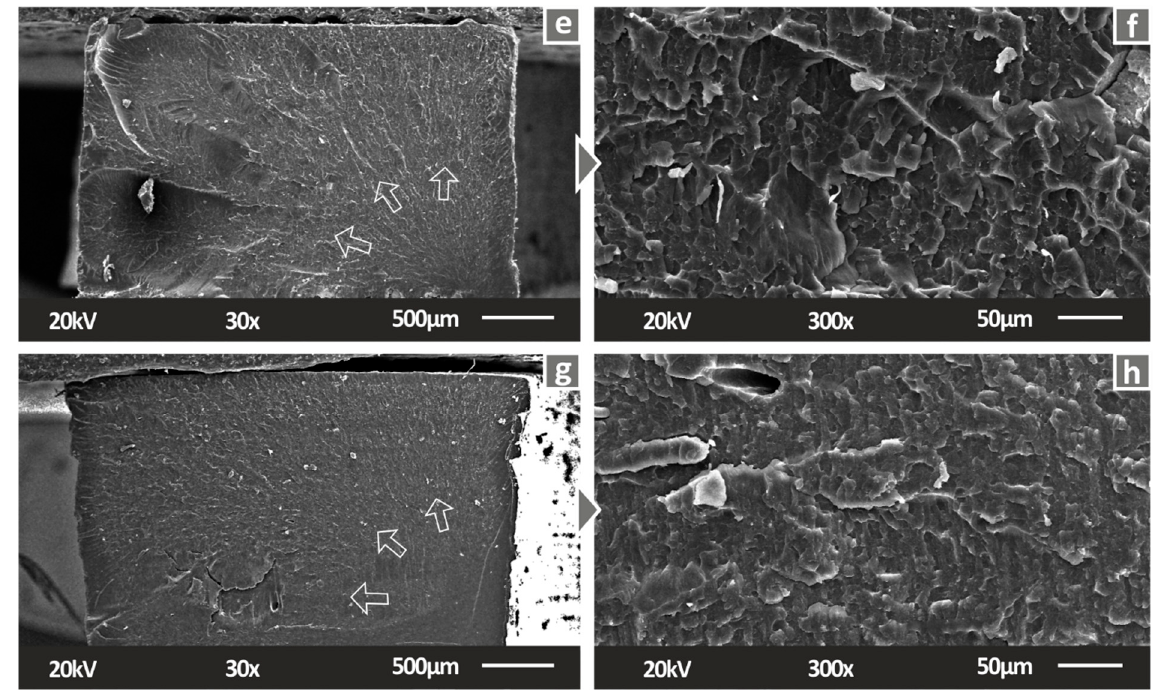
Figure 6. Fracture surface of tensile specimens in 30× magnification for ( a ) Pure SC, ( c ) SC Cu 2 O 0.5 wt.%, ( e ) SC Cu 2 O 1.0 wt.%, ( g ) SC Cu 2 O 2.0 wt.%, same surfaces in 300× magnification for ( b ) Pure SC, ( d ) SC Cu 2 O 0.5 wt.%, ( f ) SC Cu 2 O 1.0 wt.%, ( h ) SC Cu 2 O 2.0 wt.%.